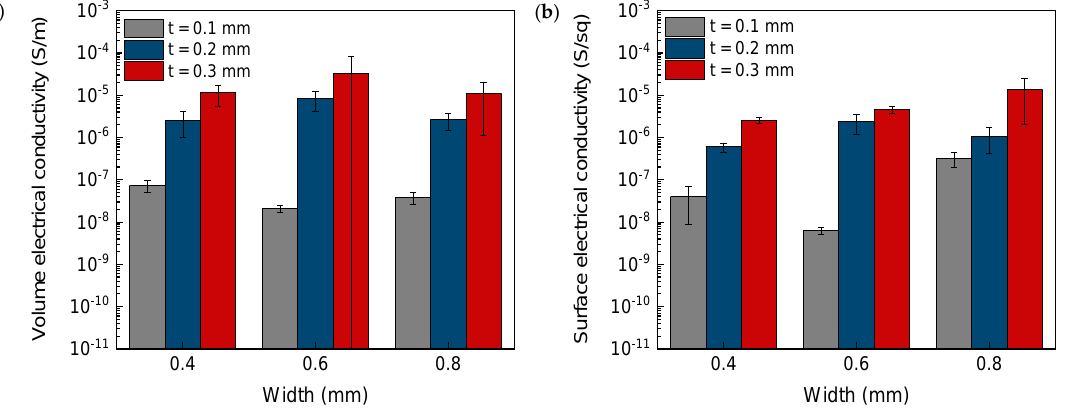
Figure 7. Volume (along Z -axis) ( a ) and surface ( b ) electrical conductivity (along X -axis) of 3D printed parts.